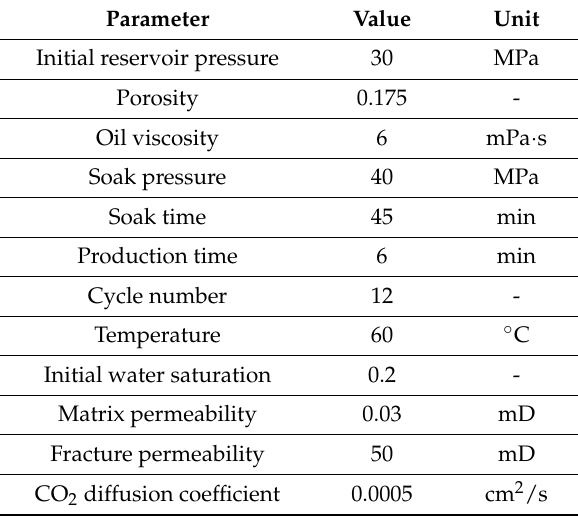
Figure 7. Relative permeability curve of the fracture. Table 2. Basic reservoir properties in the numerical model.